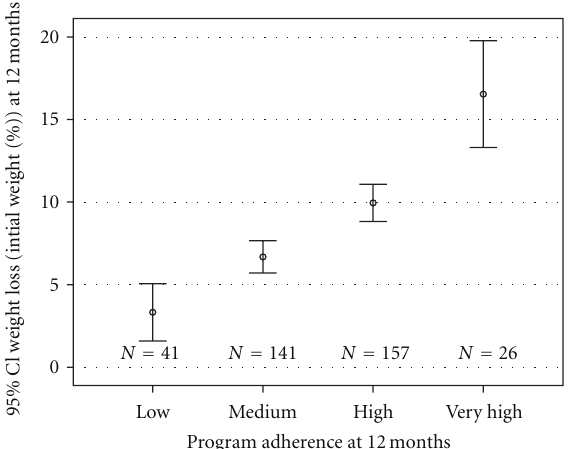
Figure 1: Program adherence and weight loss at 12 months (% of initial weight).